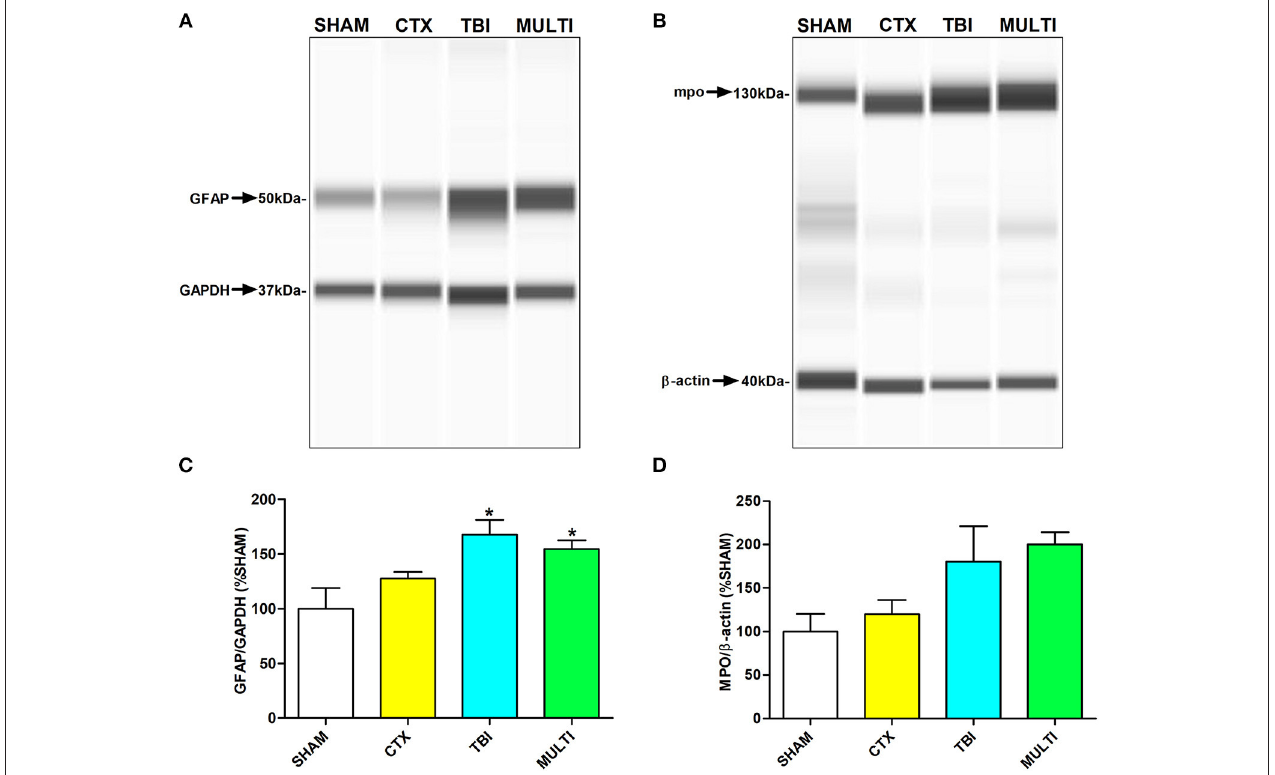
FIGURE 3 | Automated capillary Western blots were used to quantify protein expression of markers related to different immune cells in the ipsilateral cortex. (A) Pseudo-gel image of representative blots of GFAP and GAPDH for each of the four groups. (B) Pseudo-gel image of representative blots of MPO and β -actin for each of the four groups. (C) At 24h post-injury, TBI and MULTI mice had significantly increased levels of GFAP, a marker for reactive astrocytes, compared to SHAM. (D) At 24h post-injury, there was a significant effect of injury on the measure of MPO (i.e., a marker for neutrophils. Although TBI and MULTI groups appeared to have similarly elevated levels of MPO, post–hoc analyses did not reach statistical significance after Bonferroni corrections. *different than SHAM, p < 0.05. See Results for additional